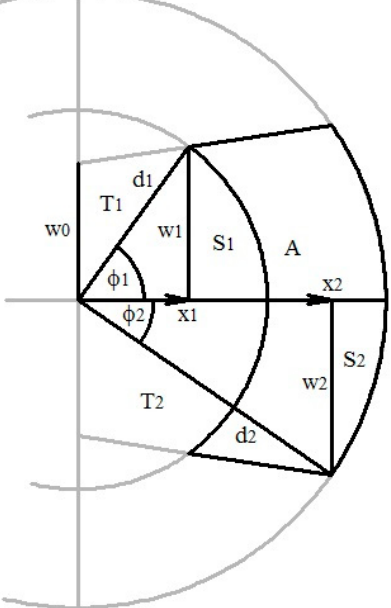
Figure 4. An illustration of the annulus containing the principal area of seabed ensonified by the sonar pulse projected onto a planar seabed. The diverging straight grey lines represent the bounds of the seabed ensonified by a sidescan sonar beam due to the narrowness in the fore–aft direction of the sonar’s beam. Top view. The direction of sonar vehicle motion is up the page.